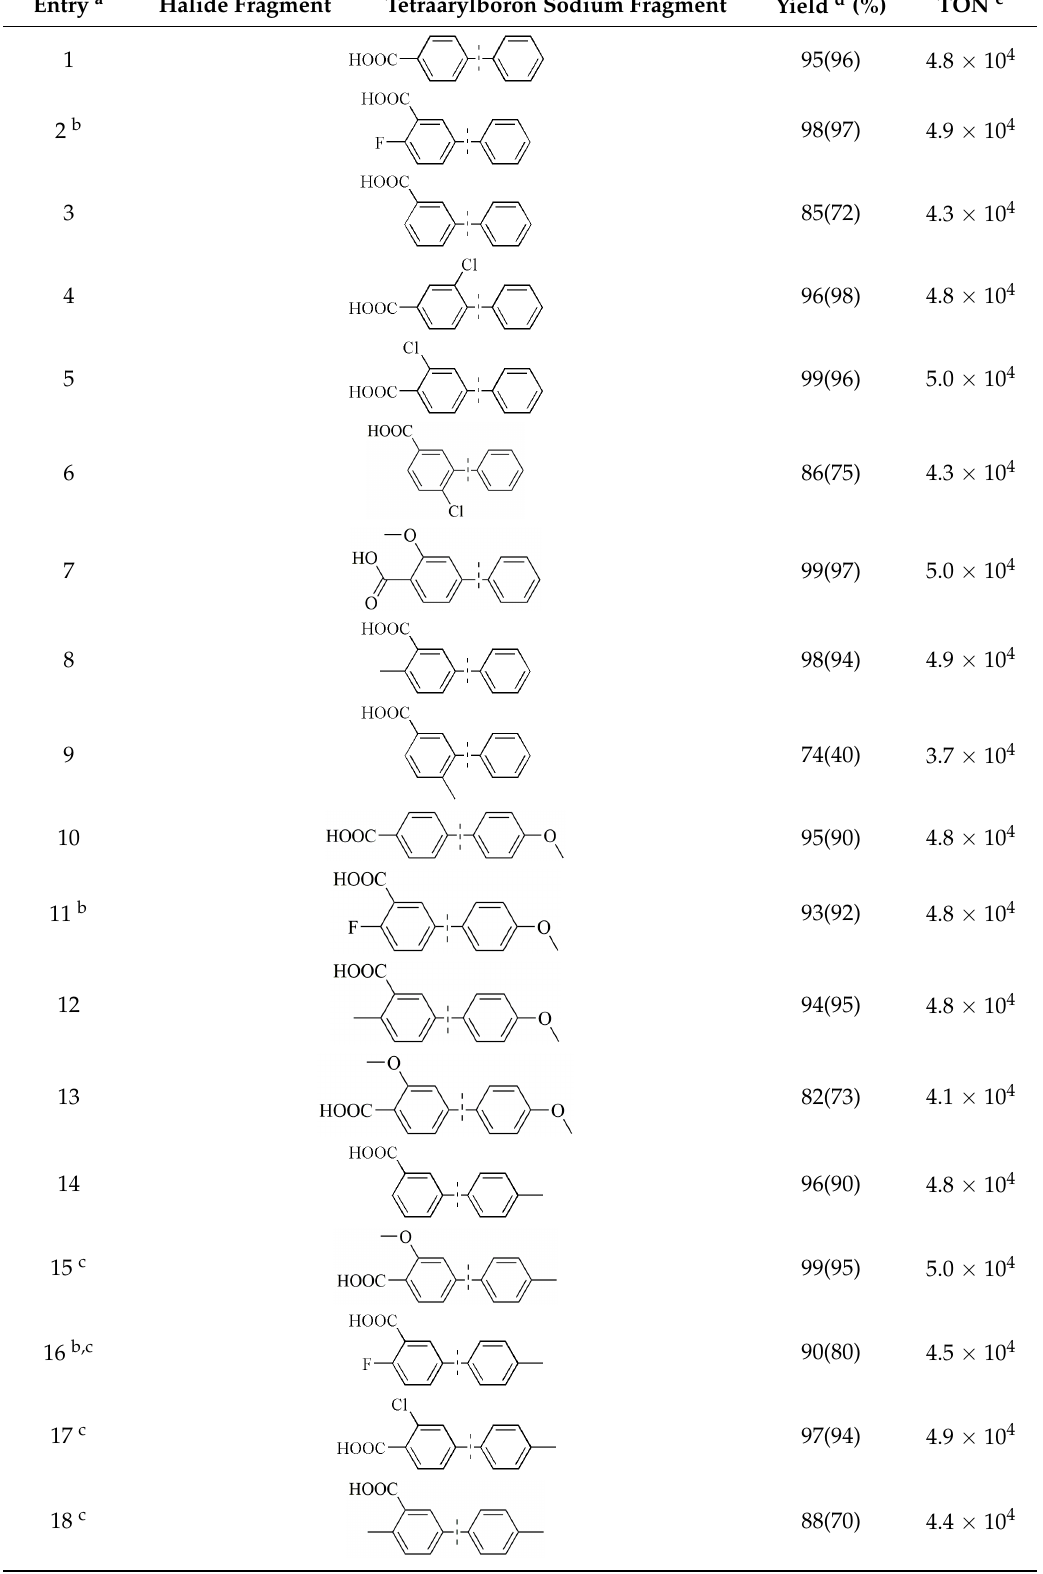
Table 2. The scope of the Pd-catalyzed Suzuki-Miyaura cross-coupling reaction.